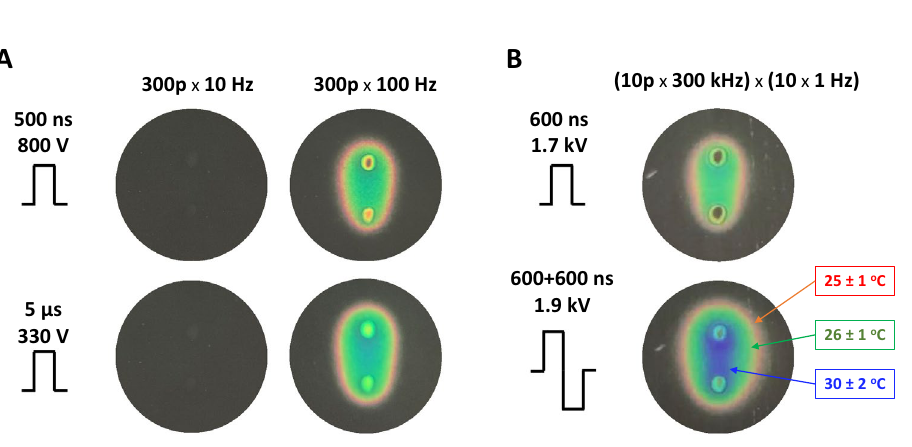
Figure 4. Monitoring the temperature rise due to PEF exposure with thermochromic liquid crystal sheets. Images were taken by the end of exposure to a train of 300 pulses at 10 or 100 Hz ( A ) or to a series of 10 bursts at 1 Hz ( B ). Each burst consisted of 10 uni- or bipolar pulses at 300 kHz. Other exposure parameters are marked in the legends. Temperatures at the color transitions are labeled in panel B according to the manufacturer’s